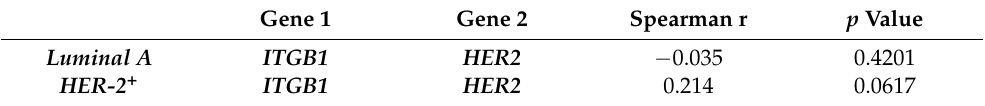
Table 2. Correlation Analysis of HER-2 and β 1 Integrin in Human Breast Cancer Patients of Luminal A and HER-2+ Subtypes using Data from the Cancer Genome Atlas (TCGA). Gene 1 Gene 2 Spearman r p Value Luminal A ITGB1 HER2 − 0.035 0.4201 0.214